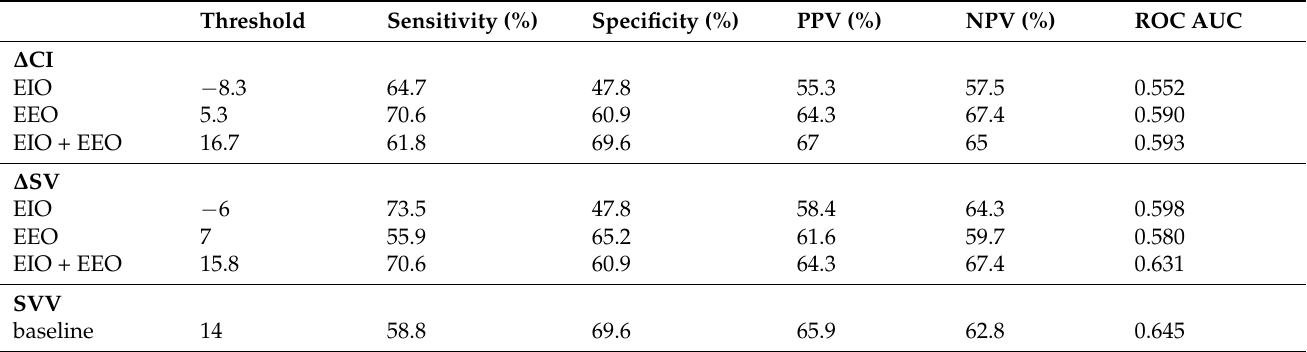
Table 5. Comparison of the ability of selected variables to predict fluid responsiveness.